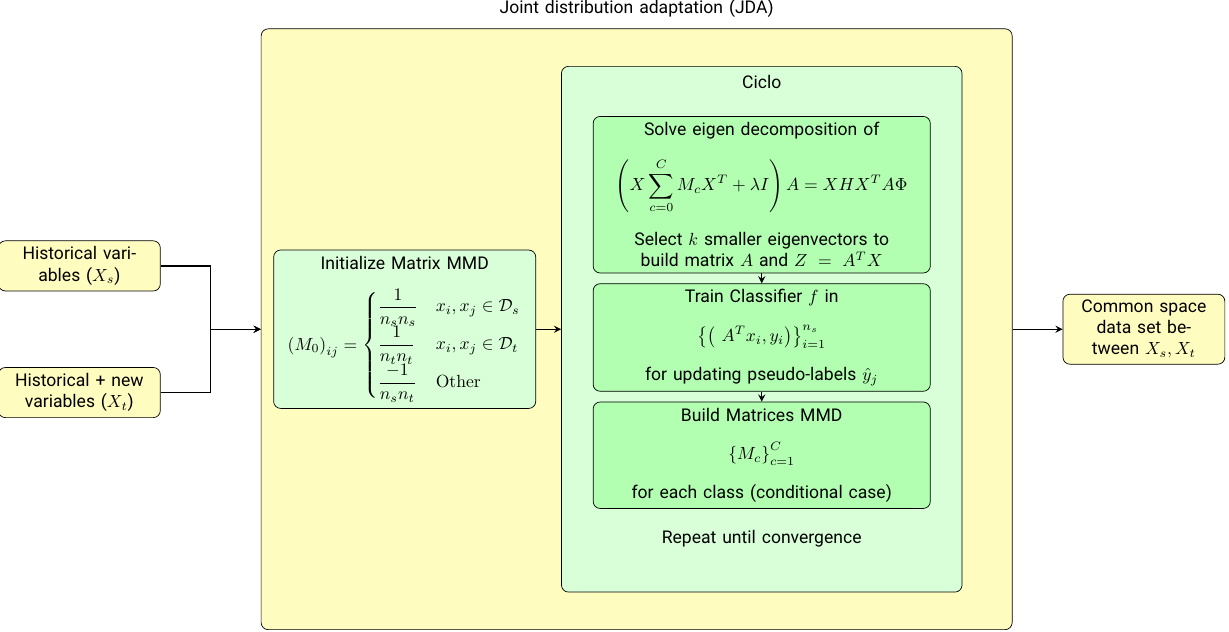
Figure 3. Transfer feature learning scheme for incorporating new variables into the cardiovascular rehabilitation model. Given that there is a difference in the number of variables in the retrospective database and those obtained for the new patients, a transfer feature learning algorithm based on dimensional reduction, the joint distribution adaptation (JDA), is proposed to combine the feature spaces of both sets of